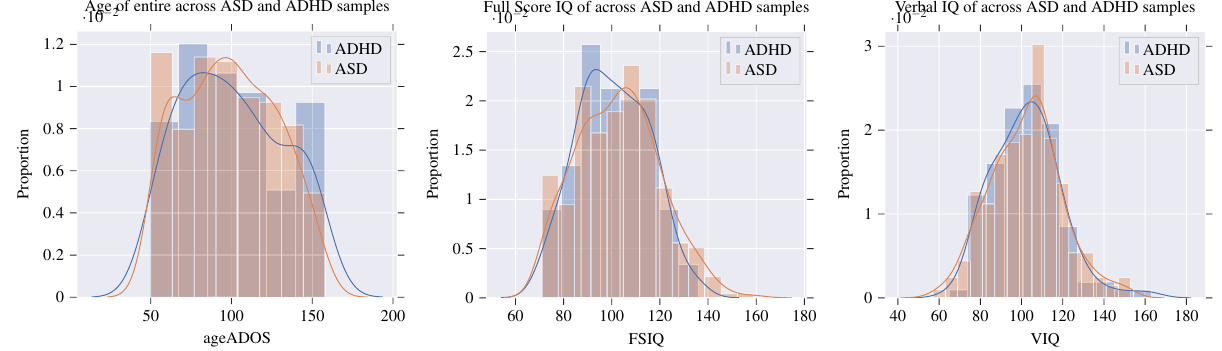
Figure 2. Distribution of demographic information: age, FSIQ and VIQ across different diagnostic conditions.